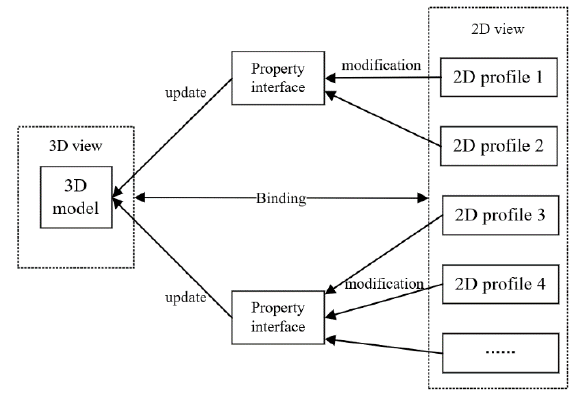
Figure 8. The binding framework for the 3D model and 2D profiles.